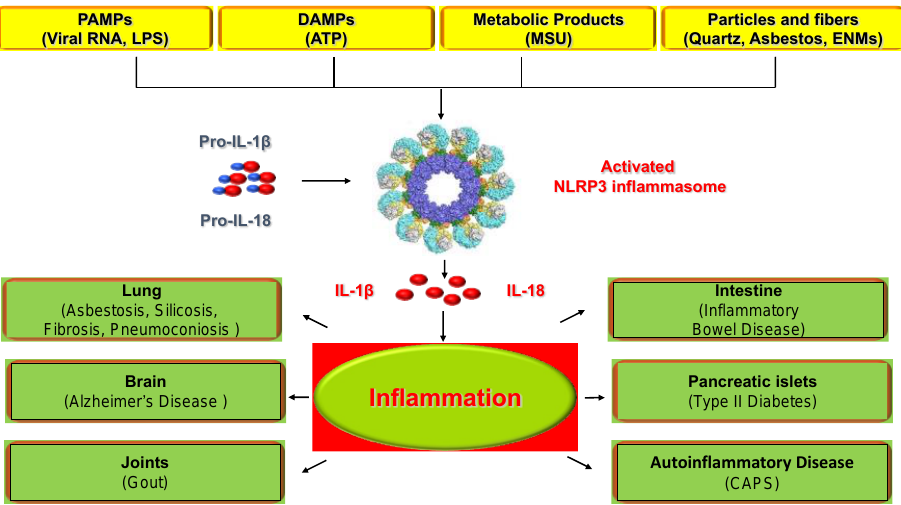
Figure 1. Stimuli for NLRP3 inflammasome activation and NLRP3 inflammasome-associated diseases. NLRP3 inflammasome is activated through a wide range of stimuli including pathogen-associated molecular patterns (PAMPs), damage-associated molecular patterns (DAMPs), metabolic products, and environmental hazards including engineered nanomaterials (ENMs). The activation of NLRP3 inflammasome and subsequent secretion of IL-1 β and IL-18 have been associated with many diseases including lung fibrosis, asbestosis, silicosis, gout, Alzheimer’s disease, inflammatory bowel disease, type II diabetes, and cryopyrin-associated periodic syndrome